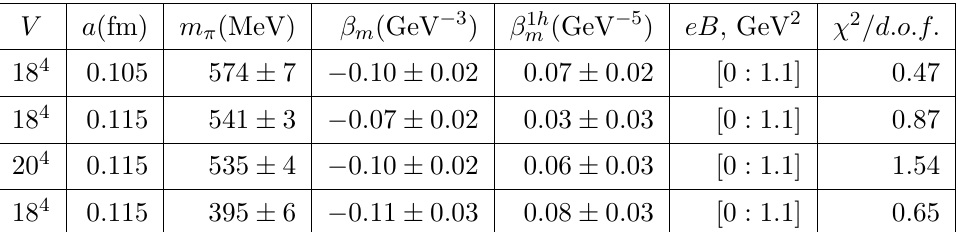
Table 5 . The value of the magnetic dipole polarizability (cid:12) m and the magnetic hyperpolarizability (cid:12) 1 h are shown for (cid:26) 0 with j s z j = 1, for the lattice volumes 18 4 and 20 4 , the lattice spacings 0 : 105 fm m and 0 : 115 fm and various pion masses. The fourth and the last columns contain the intervals of the magnetic (cid:12)eld used for the (cid:12)t and (cid:31) 2 =d:o:f: